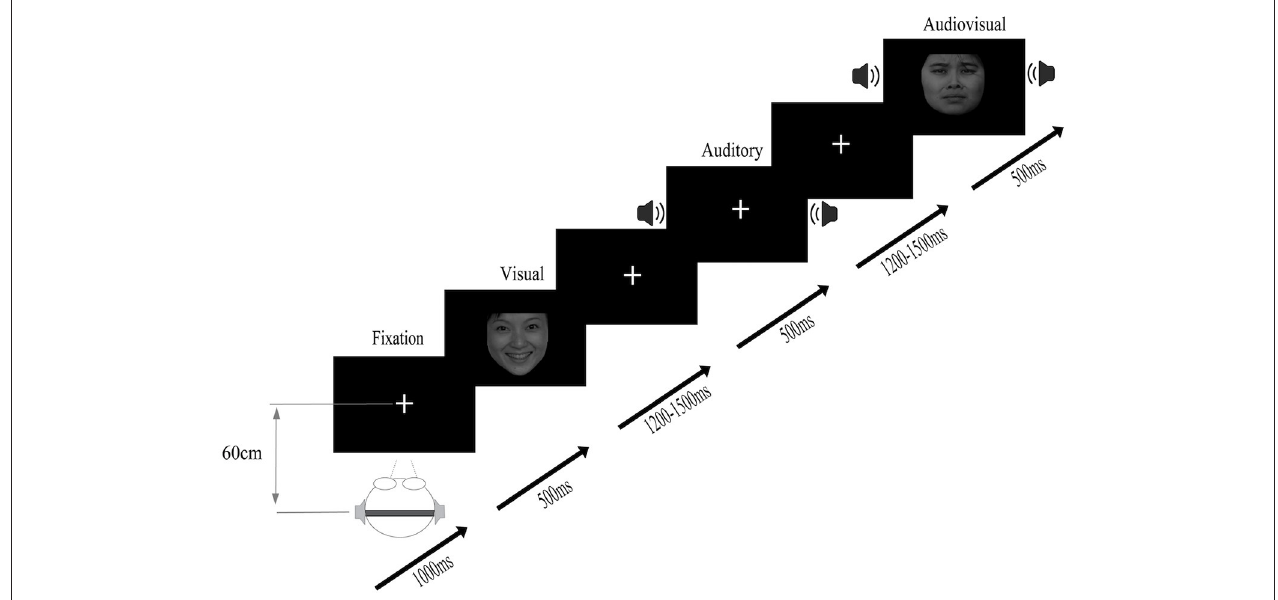
FIGURE 1 | Stimuli were randomly presented in audio, visual, and audiovisual conditions, and participants were asked to respond to target stimuli (auditory target, visual target, and audiovisual